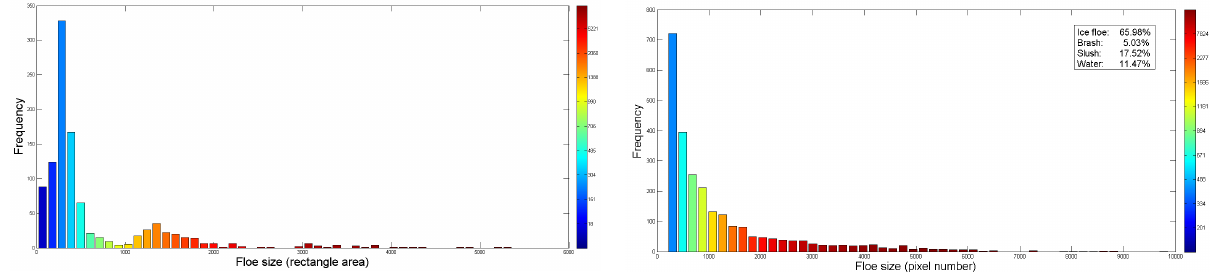
Figure 26: Floe size distribution of sea-ice image. Courtesy: Zhang and Skjetne (2015)